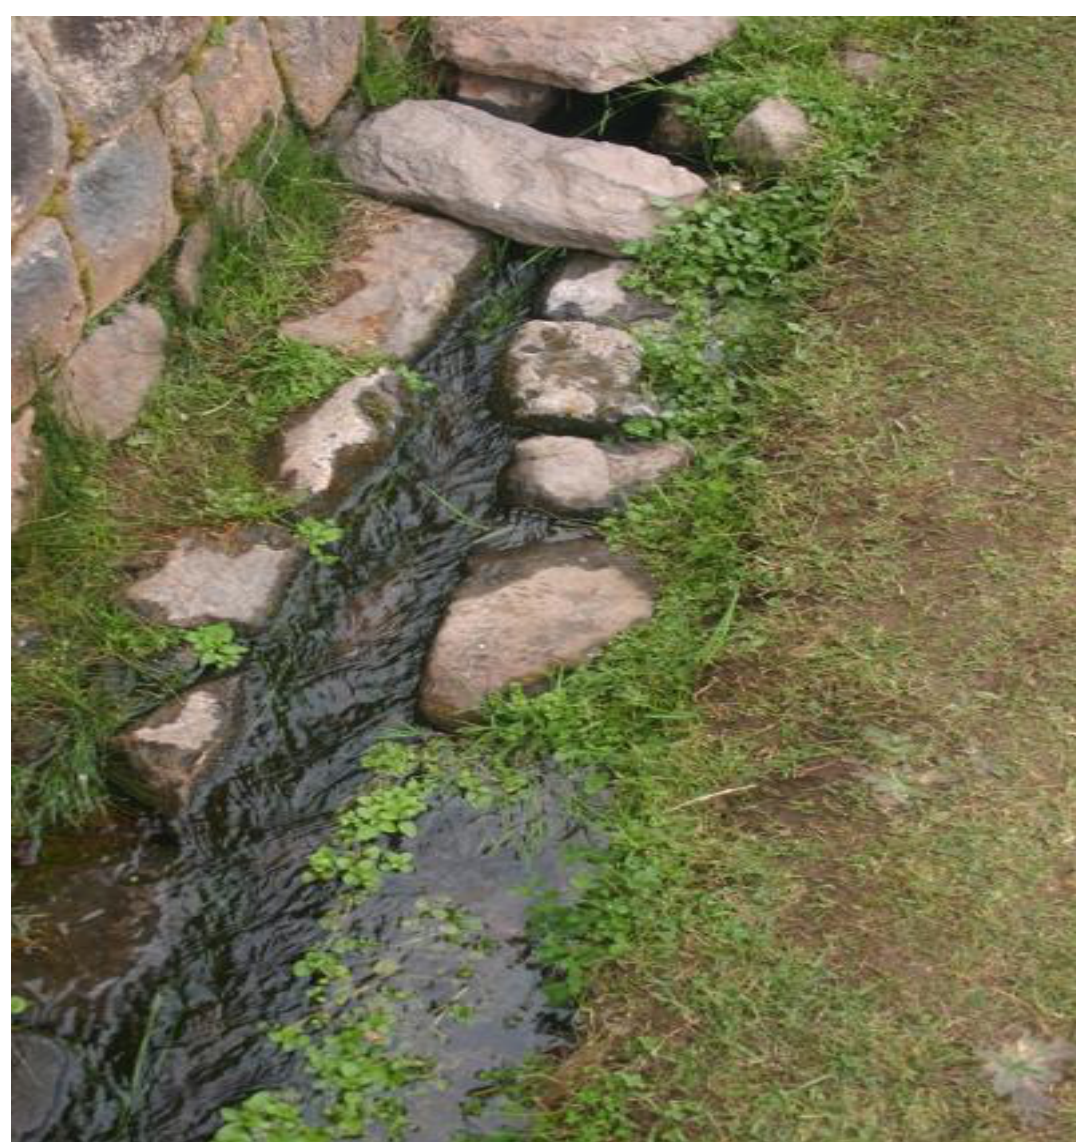
Figure 6. Typical water collection channel at the base of a lower platform shown in Figures 1 and 2. A fraction of the aquifer seepage collection water was directed further to a lower agricultural platform while remaining water was directed through a series of channels to the easternmost water collection channel and/or to lower occupation, ceremonial and reservoir areas. The easternmost collection channel is located to the right of the terraces shown in Figure 2. (Photo by C. Ortloff).